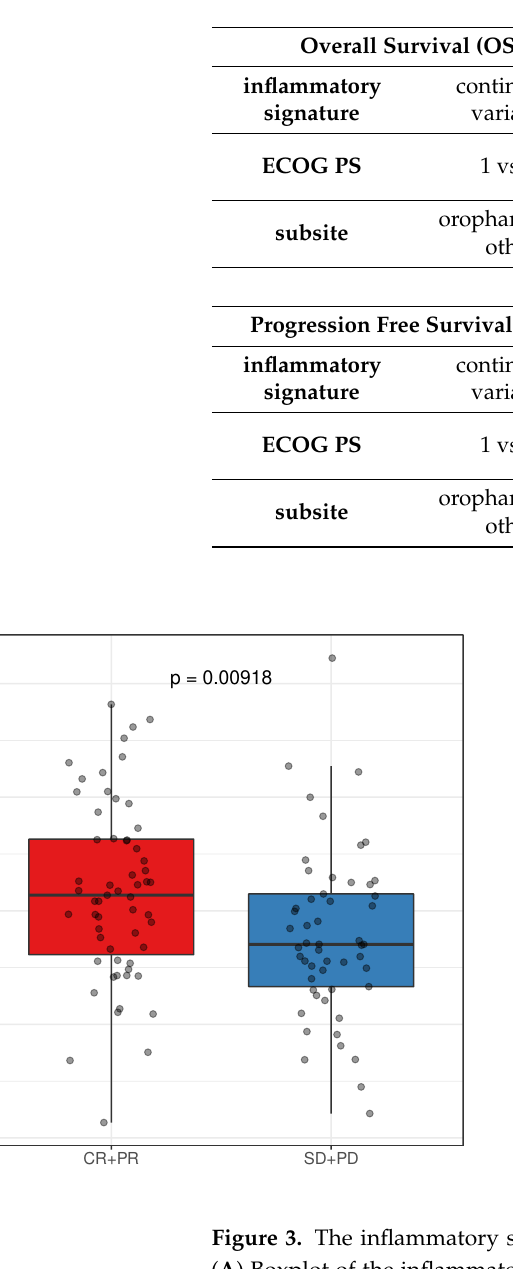
Figure 3. The inflammatory score as continuous variable was associated to cetuximab response. ( A ) Boxplot of the inflammatory scores in responders (complete responders + partial responders, CR + PR) and non-responder (stable disease + progressive disease, SD + PD). The inflammatory score is based on scaled expression of the four genes retrieved from normalized RNAseq data, ( B ) receiver operating characteristics (ROC) curve and area under the curve (AUC) of the four-gene inflammatory